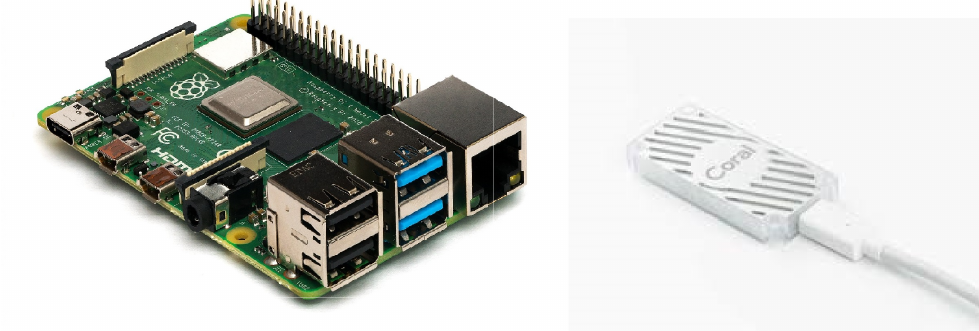
Figure 7. From left to right: Raspberrypi (https://www.raspberrypi.com/, accessed on 15 November 2021), and Google coral USB Accelerator (https://coral.ai/, accessed on 8 November